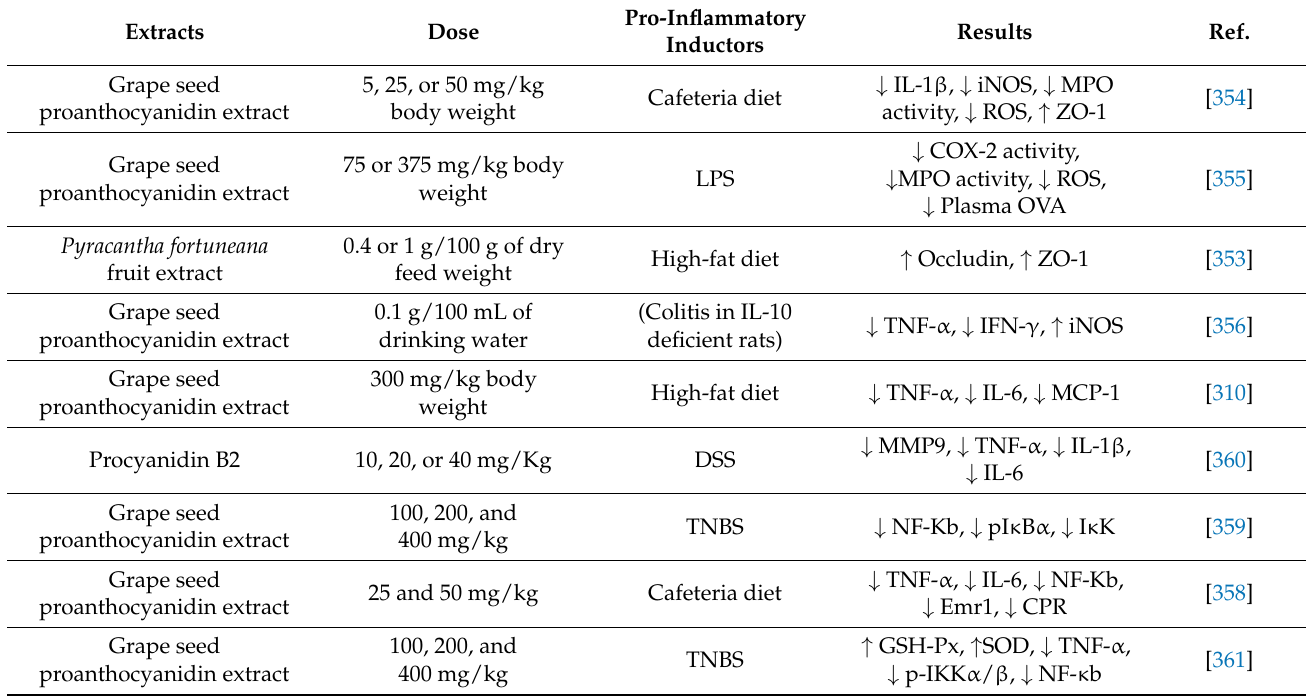
Table 5. In vivo studies reporting the anti-inflammatory activity of